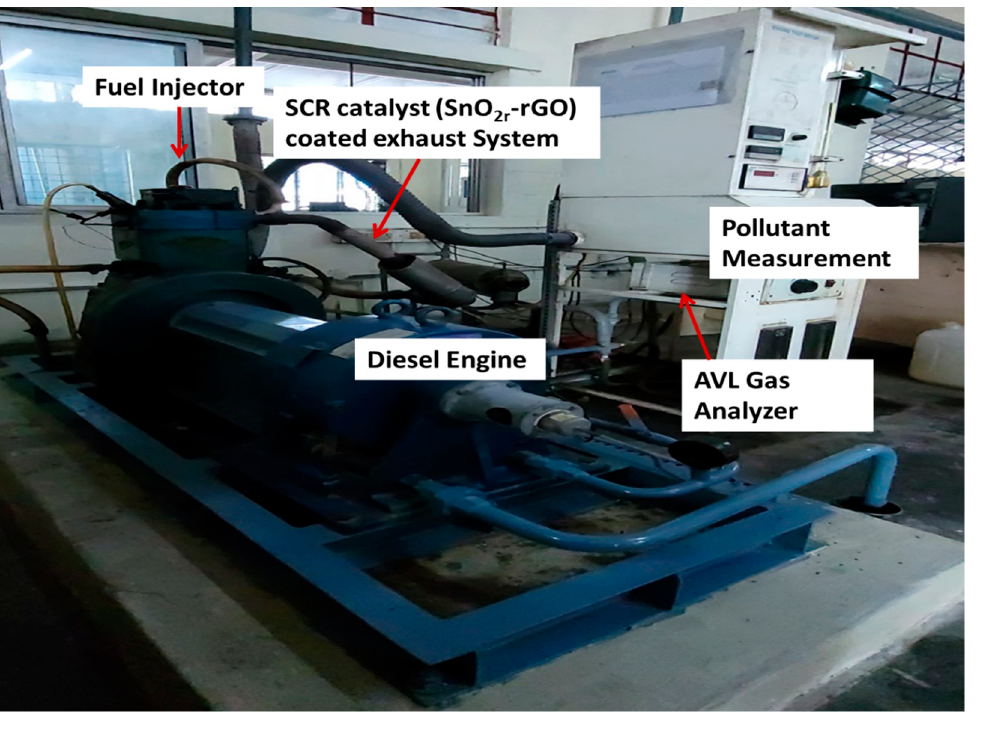
Figure 9. Engine experimental setup.